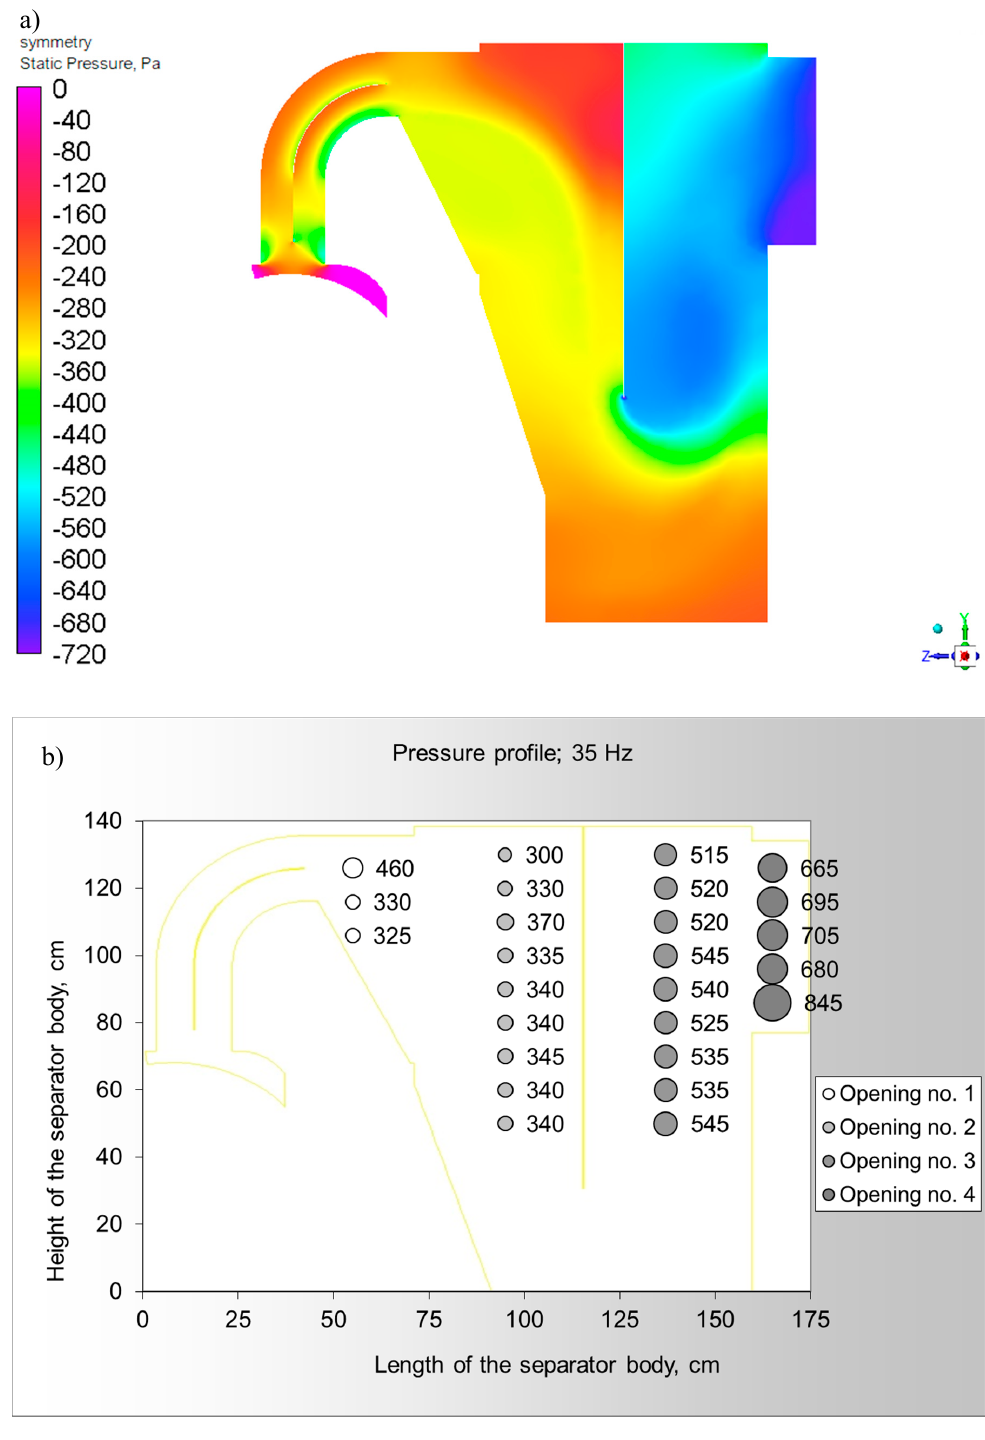
Figure 11. Pressure profile in the sorter symmetry plane (simulation of the main fan at 35 Hz): ( a ) numerical model (gauge pressure) and ( b ) measured (negative pressure).